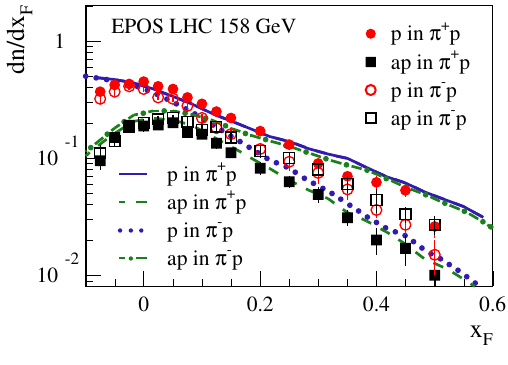
Figure 7. Number of protons and antiprotons produced in π + and π − interactions with protons at 158 GeV laboratory energy as a function of the Feynman momentum fraction x F . Data from NA49 [24] (points) are plotted together with E pos LHC simula- tions